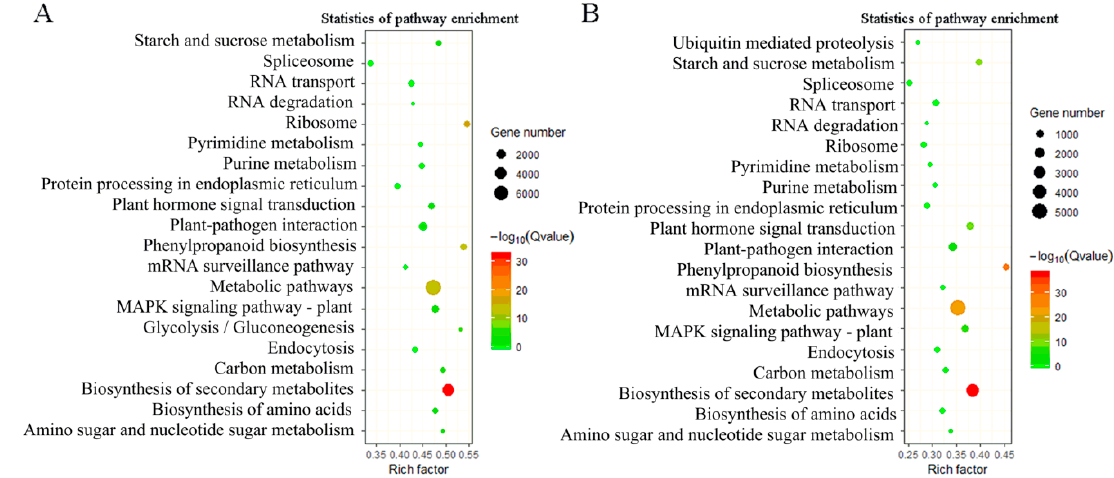
Figure 6. Enrichment of di ff erentially expressed genes (DEGs) in KEGG pathway. ( A ) Significantly enriched pathways for DEGs in leaf versus root tissues. ( B ) Significantly enriched pathways for DEGs in stem versus root tissues. The x-axis represents the rich factor (the value of the enrichment factor, which is the quotient of the foreground value (number of DEGs) and background value (total gene amount)), and the y-axis represents KEGG